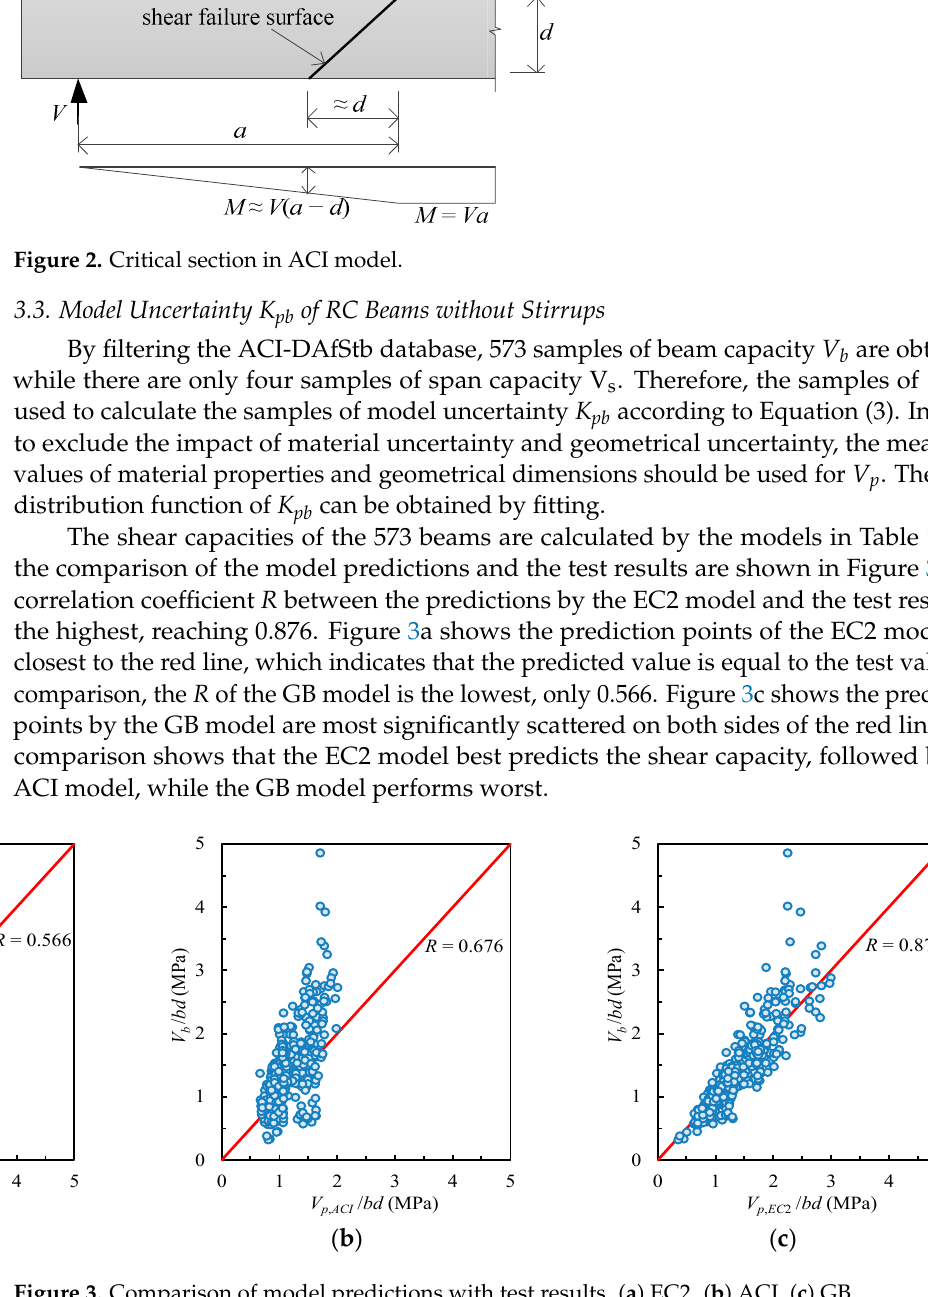
5 of 13 Table 1. Shear capacity models for RC beams without stirrups in the codes. Code